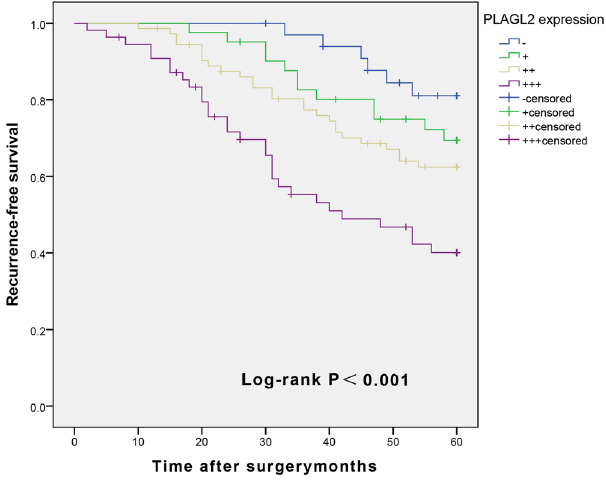
Figure 3. Survival curve of PLAGL2 expression and 5-year RFS rate in patients with BUC after radical cystectomy and pelvic lymphadenectomy (Patients with overexpression of PLAGL2 have a shorter RFS time relative to those with lower expression (log-rank test, P < 0.001).